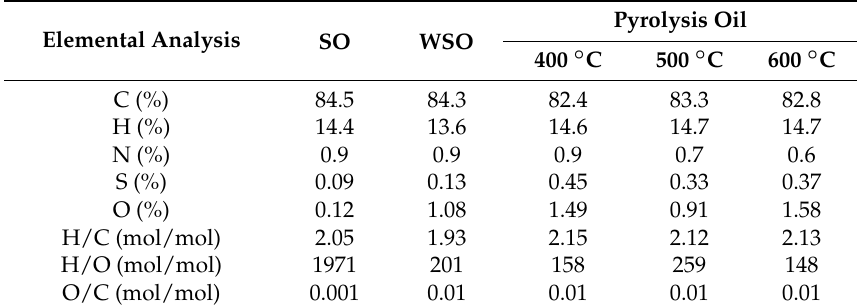
Table 2. Elemental analysis (wt. %) of the original shipping oil (SO), waste shipping oil (WSO) and pyrolysis oil.